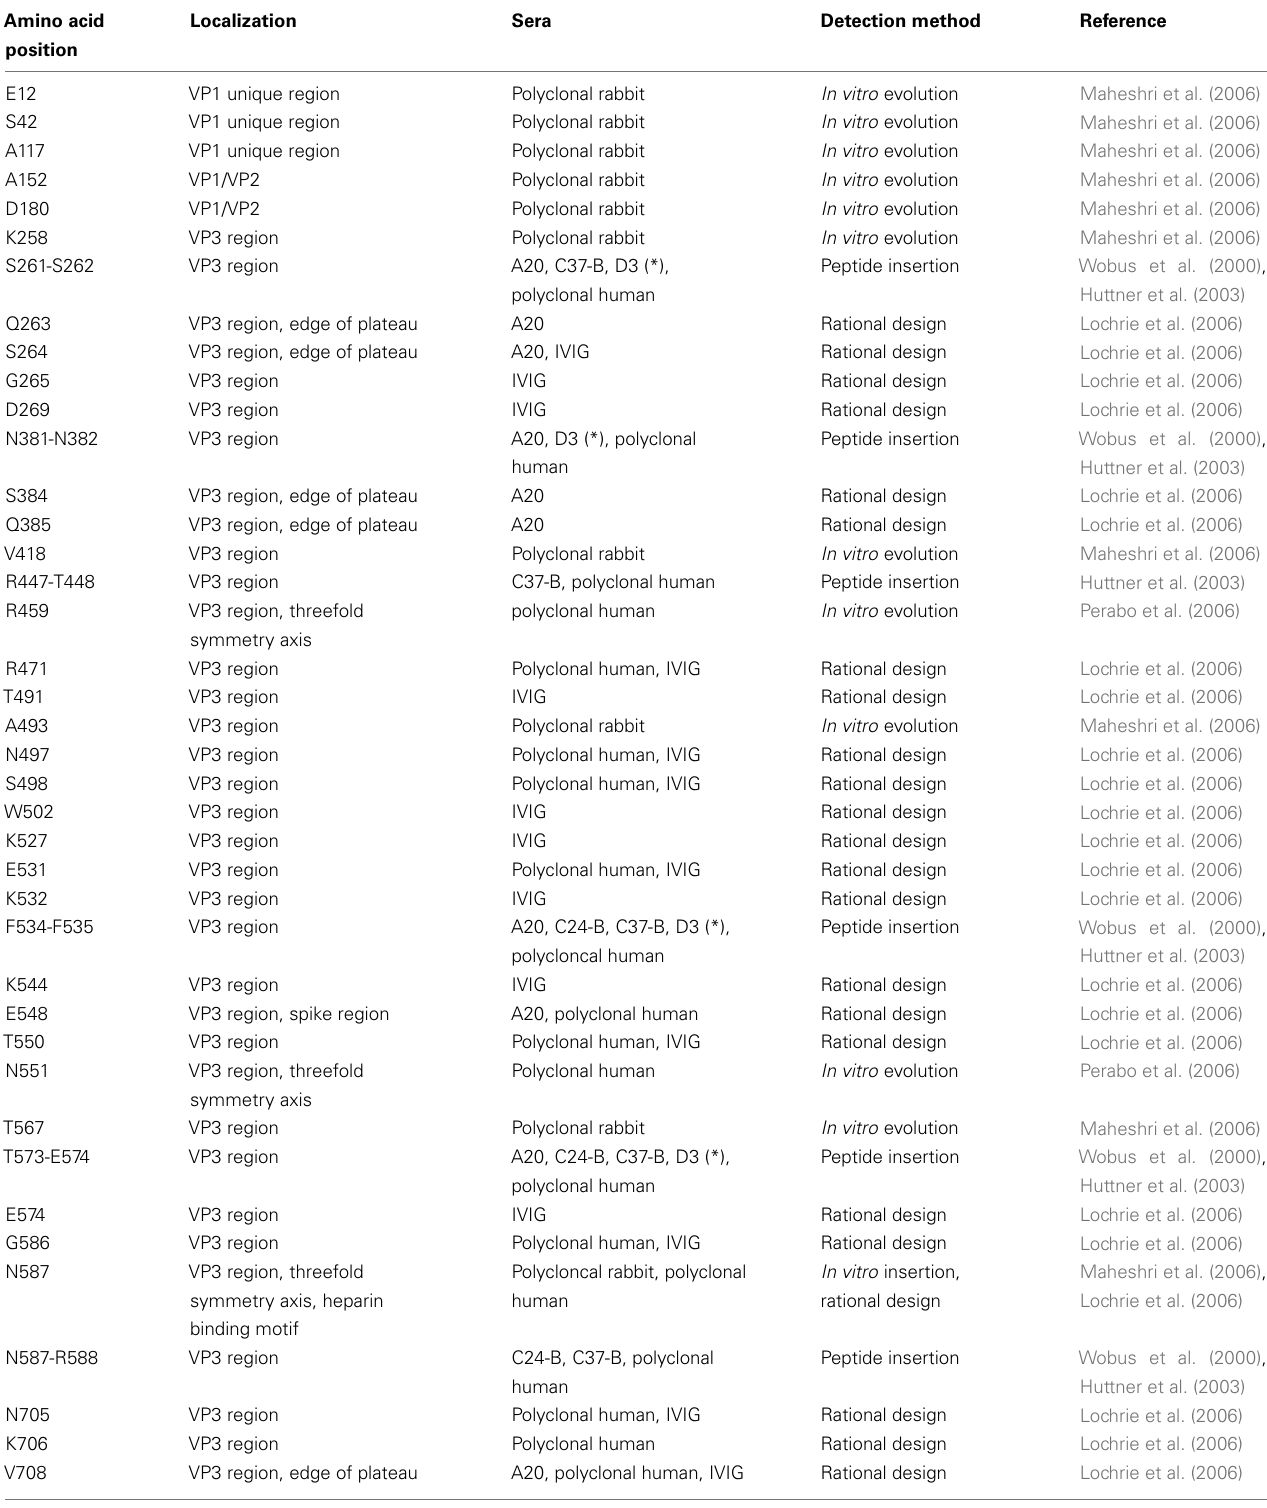
Table 2 | Immunogenic sites at theAAV2 capsid # . Amino